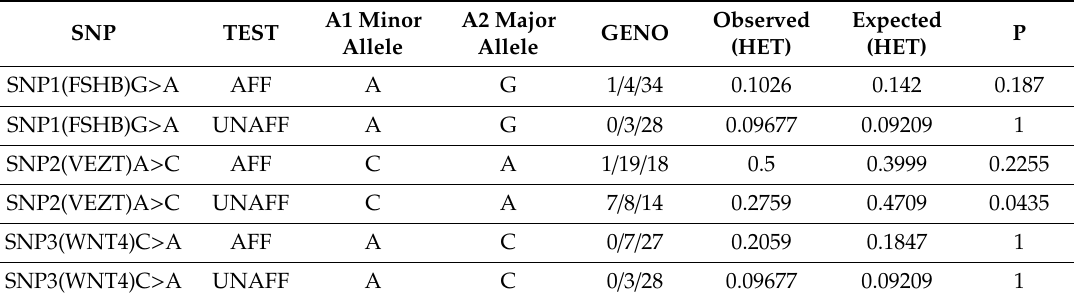
Table 4. Expected and observed frequencies and HWE p -values for SNPs investigated in groups of a ff ected cases and healthy controls.